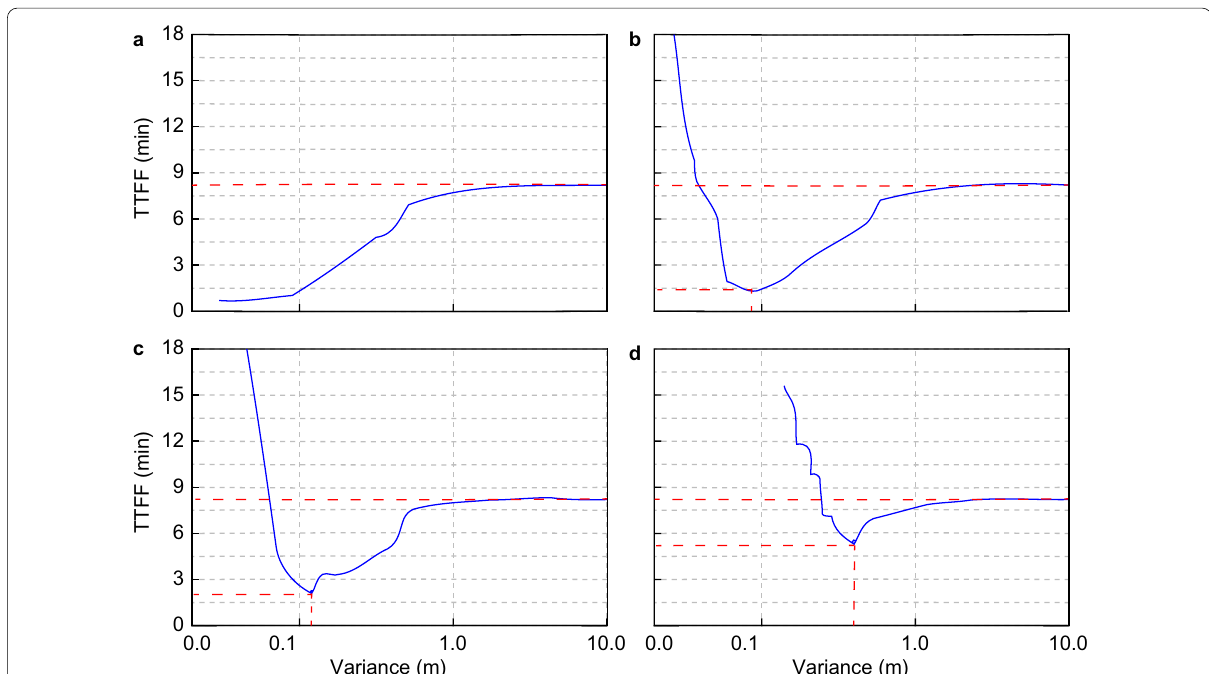
Fig. 9 The convergence time of the PPP–RTK constrained by external ionospheric delay information with an error of a 0, b 1 TECU, c 3 TECU, and d 5 TECU for different variances